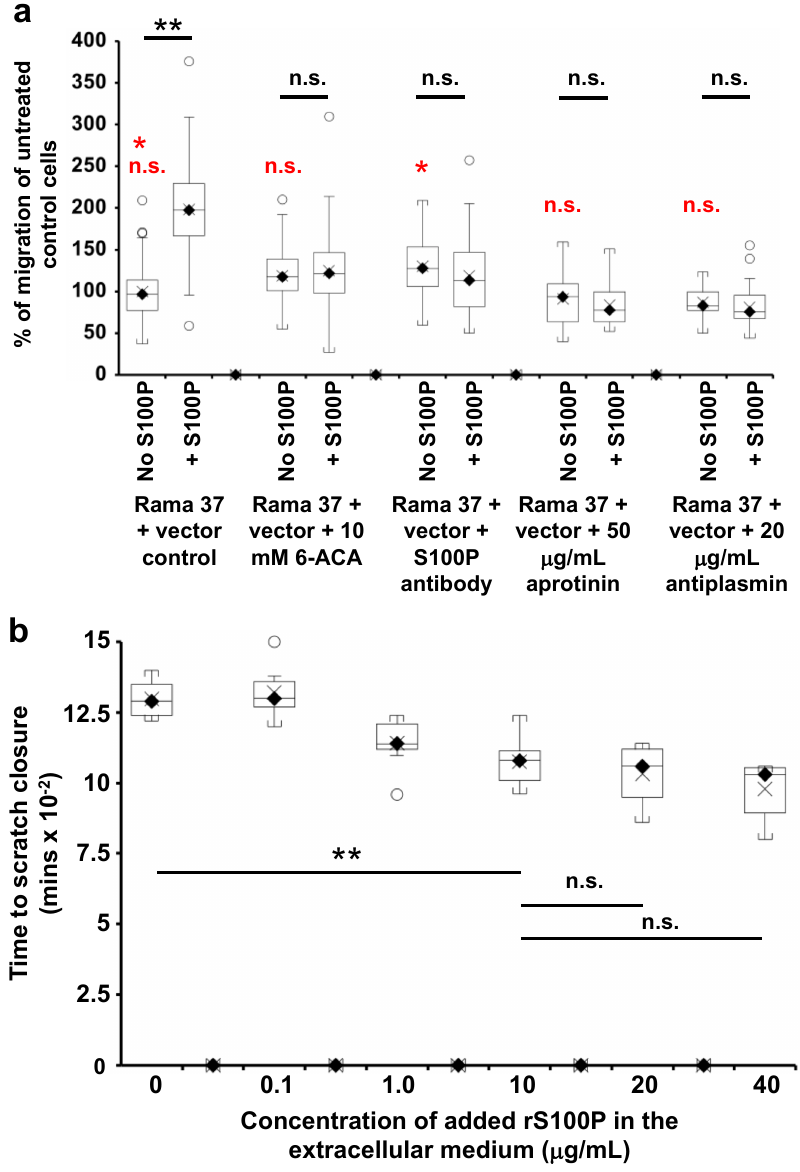
Figure 4. Effect of extracellular addition of S100P on migration of S100P non-expressing cells in Transwell and scratch-wound migration assays. ( a ) Transwell migration assays were carried out as described in Materials and Methods. The number of S100P-negative Rama 37 empty-vector-transfected control cells passing through to the underside of the membrane in 16 h in the presence of 10 mM 6-ACA (Rama 37 + vector + 10 mM 6-ACA), R&D Systems polyclonal goat S100P-specific antibody, Cat. No AF2957 at a concentration of 0.2 ng/ µ L in the medium (Rama 37 + vector + S100P antibody), 50 µ g/mL aprotinin (Rama 37 + vector + 50 µ g/mL aprotinin), or 20 µ g/mL α -2-antiplasmin (Rama 37 + vector + 20 µ g/mL antiplasmin), either in the absence (No S100P) or in the presence (+ S100P) of 10 µ g/mL recombinant S100P (rS100P) were counted and are plotted as a percentage of the mean of untreated Rama 37 + vector control cells (Rama 37 + vector control). Each box and whisker plot shows the dispersion of data from 60 separate data points from 4 independent experiments (control, 6-ACA, S100P antibody) or 10 to 30 data points from 2 independent experiments (aprotinin and antiplasmin) carried out at different times. ( b ) Rama 37 cells transfected with empty expression vector were subjected to scratch-wound assays in the absence of or in the presence of various concentrations of rS100P added to the extracellular medium and the time-to-scratch-closure recorded for 9 separate wells in two independent experiments carried out at different times. For both ( a ) and ( b ), p -values are indicated for comparison between the box and whisker plots beneath the ends of the horizontal lines as n.s. not significant ( p > 0.05) or significant ** ( p < 0.0001). In ( a ), for clarity, some p -value comparisons are shown without lines and in red colour, as follows: n.s., no- S100P controls for 10 mM 6-ACA, 50 μ g/mL aprotinin, and 20 μ g/mL α -2-antiplasmin are not sig- nificantly different from the no-S100P, no-addition control ( p = 0.055, 0.946, 0.932, respectively, Dun- nett post-hoc test), or * no S100P for 0.2 ng/ μ L S100P antibody, significantly faster than the no-S100P, no-addition control ( p = 0.0002). In all boxes for ( a , b ), the black diamond and line show the median value; the cross shows the mean value. The white circles outside the whiskers denote outliers of >1.5 times the interquartile range. 4. Discussion For the first time, it is shown here that removing or replacing the single C-terminal lysine residue of S100P protein with alanine significantly reduces its ability to promote metastasis in a well-established animal model [23]. In this animal model metastasis is pre- dominantly to lungs and, over a longer time frame, to liver. The present experiments were terminated after 2 months, so liver metastases were not observed. Human breast cancer also metastasises eventually to the bony skeleton. Although most of the changes in the C- terminal lysine showed a significant reduction in metastasis, the pool of K95A S100P transfectants did not, suggesting that more rats than the 19 used were needed to achieve